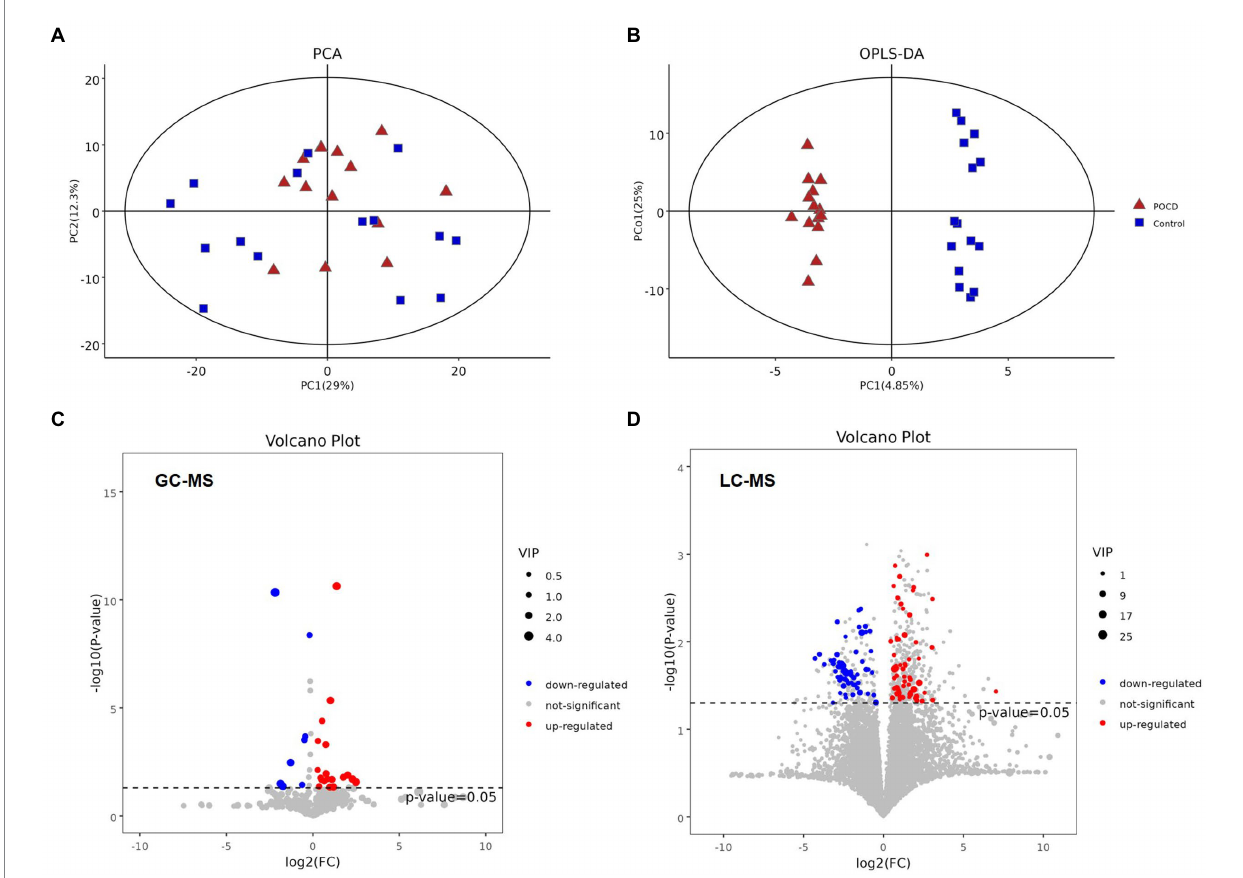
FIGURE 4 (A,B) It showed significant differences between two groups at the metabolic profiling level both in PCA and OPLS-DA ( R 2 = 0.961, Q 2 = − 0.268), (C,D) Differential metabolites between the two groups performed by T-test, and visualization by their value of ps and Fold change values using volcano plots. The red dots represent metabolites that were significantly upregulated in the POCD group, the blue dots represent metabolites that were significantly downregulated and the grey dots represent metabolites that were not